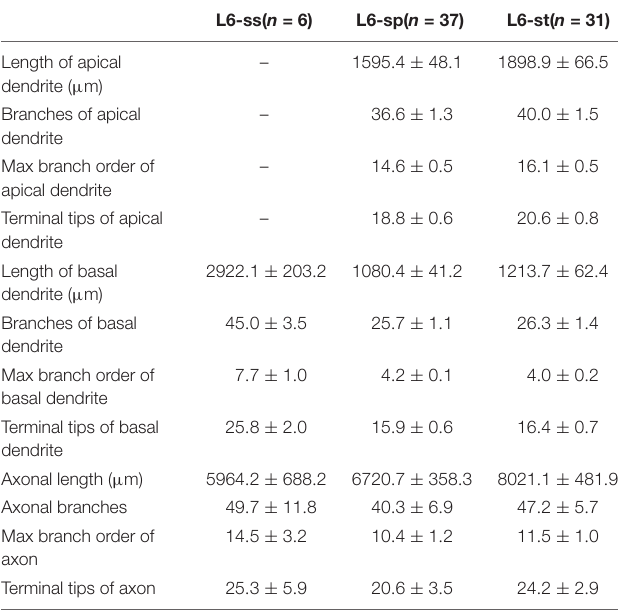
TABLE 2 | Morphological statistics of excitatory neurons in layer 6 of visual